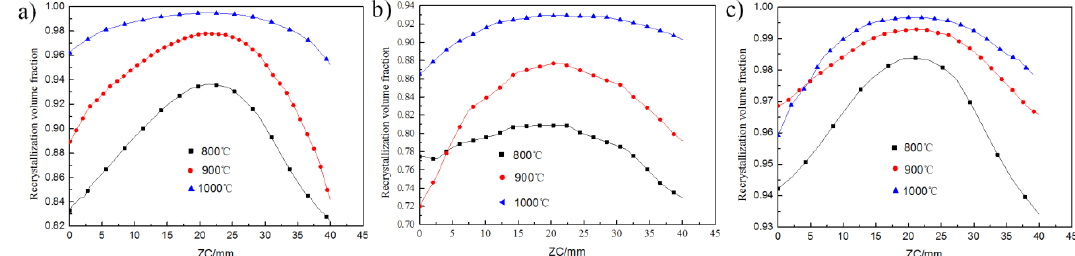
Figure 10. Recrystallization volume fraction (RVF) curve of forgings at different temperatures under different processes: ( a ) CMDF, ( b ) single-open MDF, and ( c ) double-open MDF.